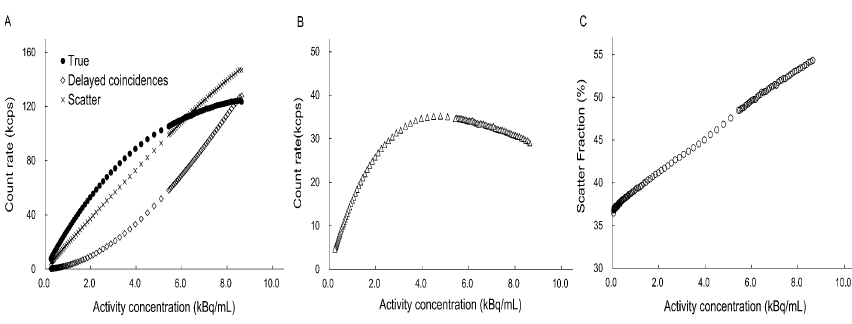
Fig. 3 Count rate performance plots. a True, delayed coincidences, and scatter count rates. b Noise‑equivalent count rate as a function of activity concentration. c Scatter fraction as a function of activity concentration